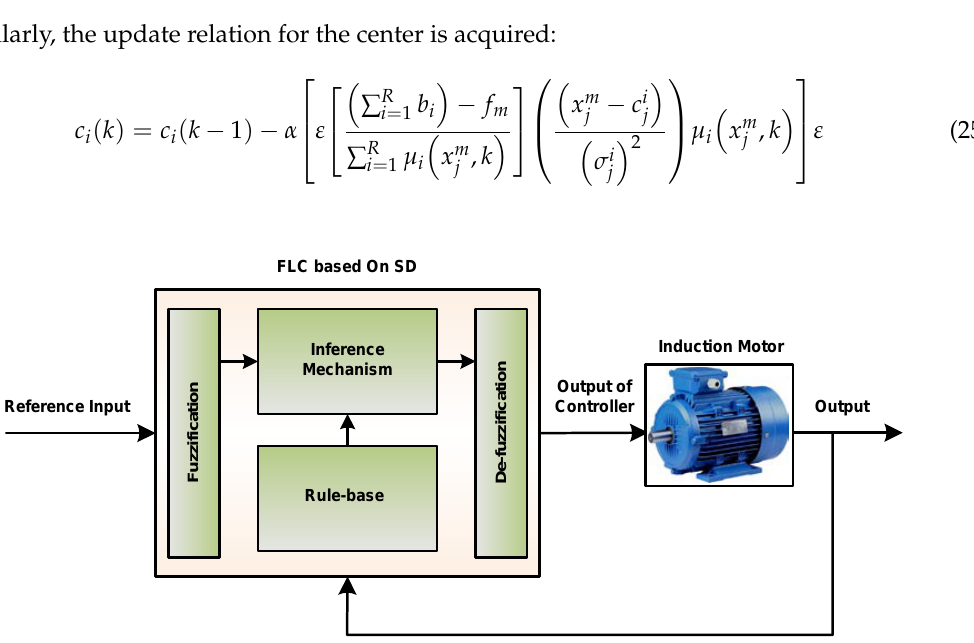
Figure 8. FLC based on the Steepest Descent (SD).